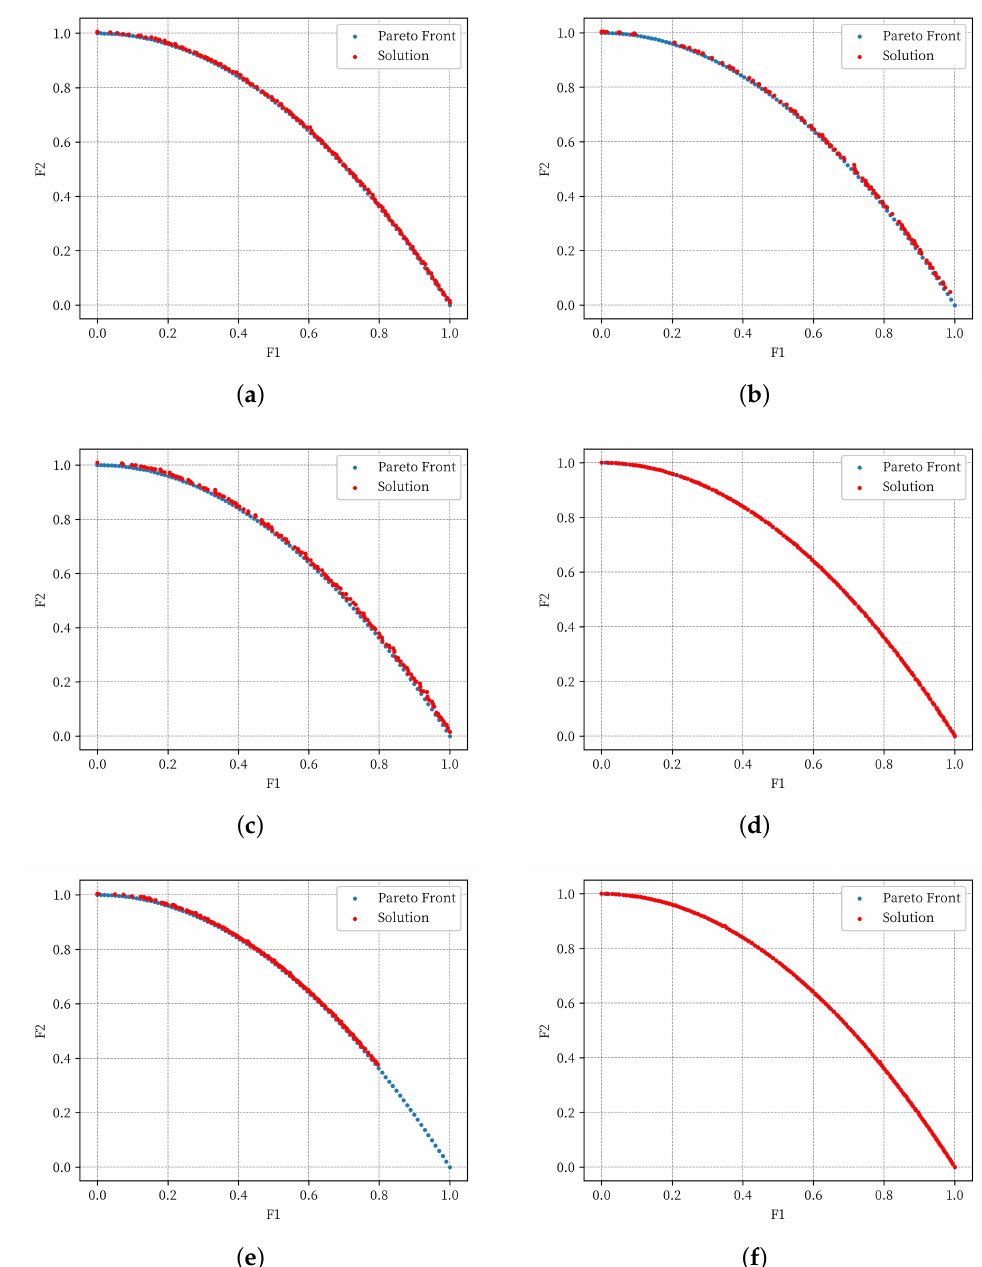
Figure 4. Comparison Between the Pareto Front and the Final Population Solution Set Obtained by the Six Different Algorithms on ZDT2 Test Problem Set. Subfigures ( a ) AGEMOEA, ( b ) MOEA/D-URAW, ( c ) NSGA-II-SDR, ( d ) CMOPSO, ( e ) MOEA/D-DAE, and ( f ) MOEA/D-DPAW correspond to the running results of algorithms AGEMOEA, MOEA/D-URAW, NSGA-II-SDR, CMOPSO, MOEA/D- DAE, and MOEA/D-DPAW,